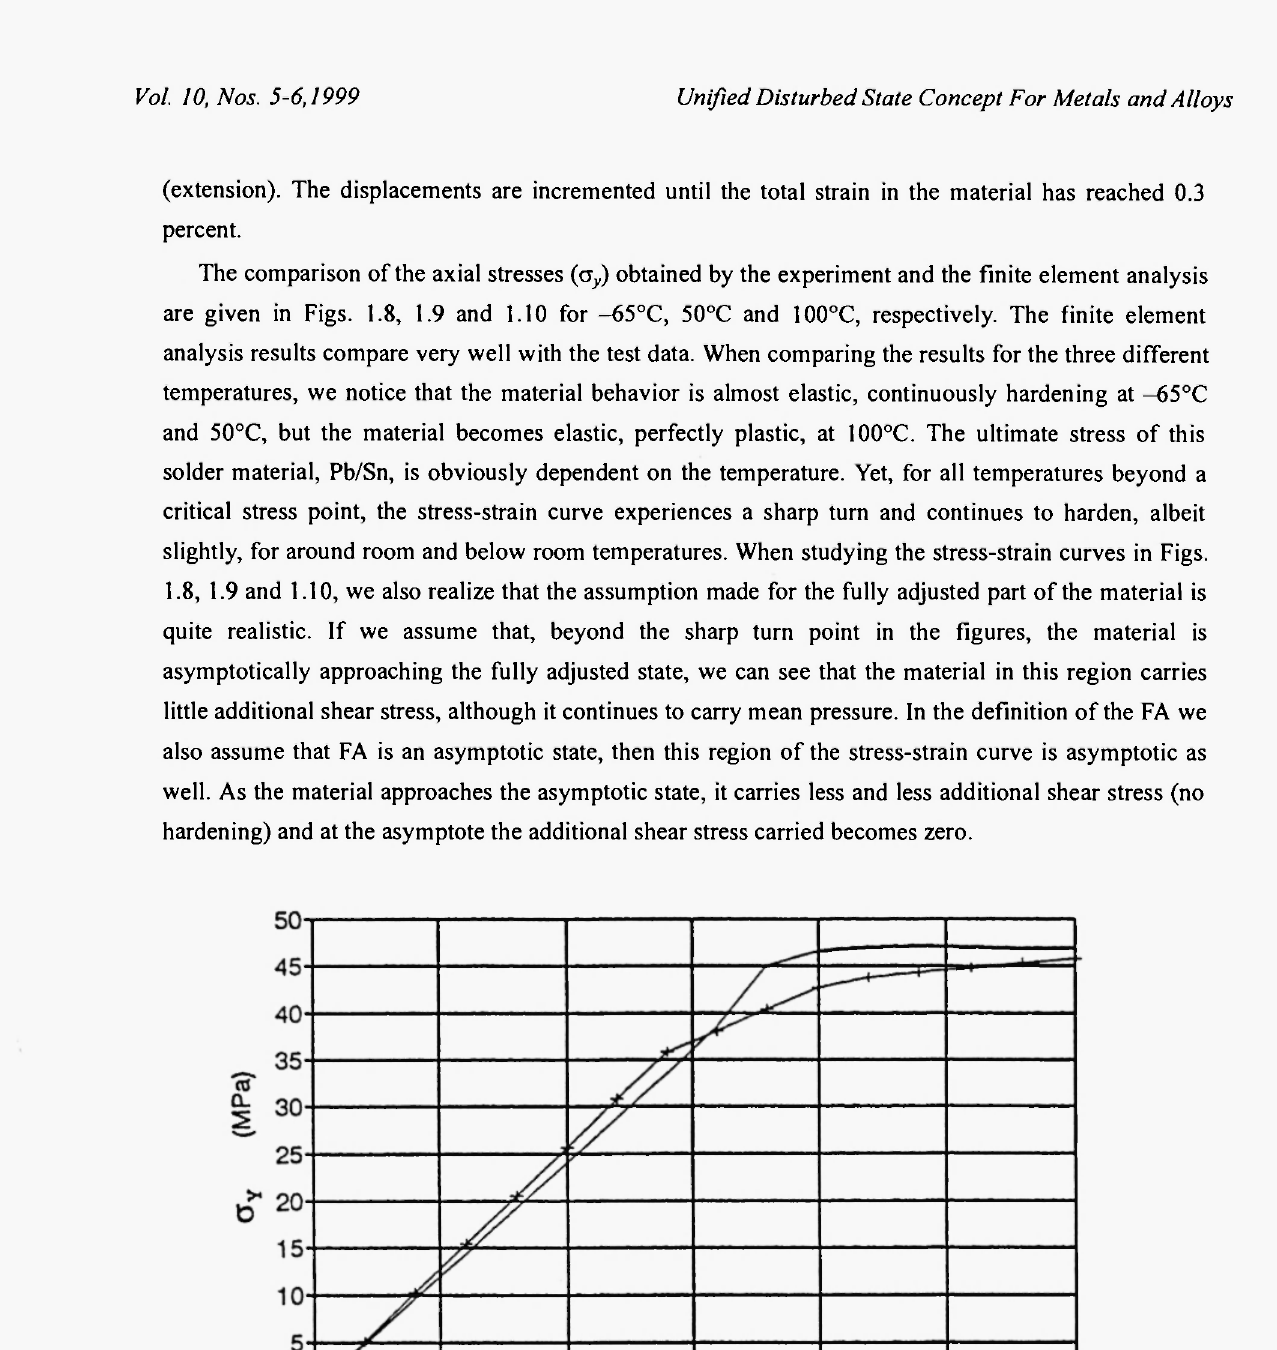
Fig. 1.8: Thermo elasto-plastic finite element analysis results vs. uniaxial extension test data for Pb37/ Sn6 solder alloy block at